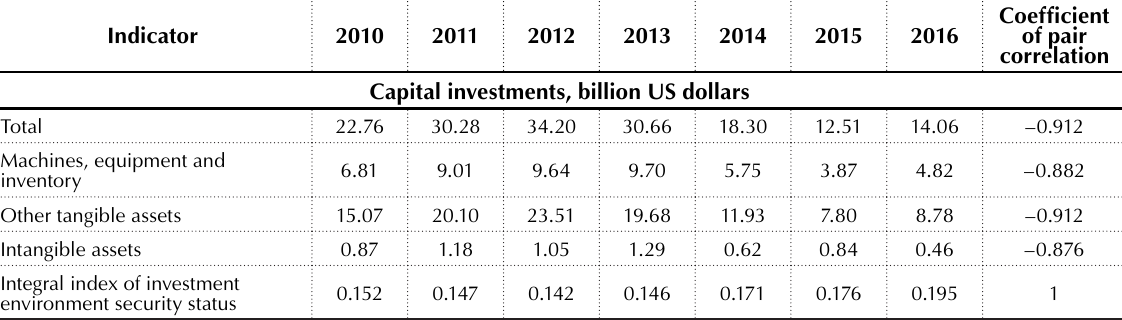
Table 2. Correlation between the integral index of investment environment security and capital investments in Ukraine for